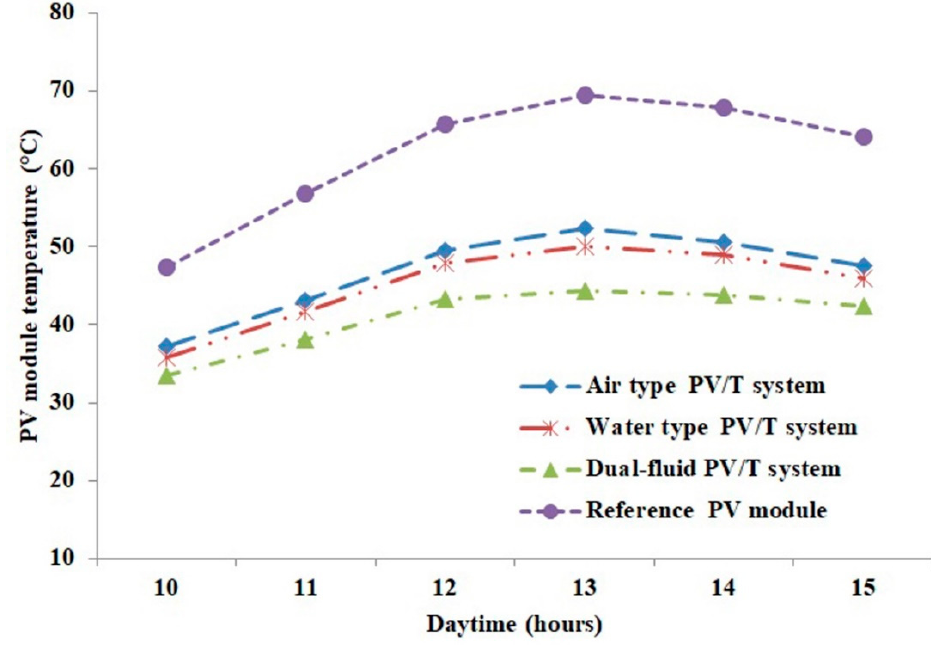
Figure 5. Daily photovoltaic (PV) module temperature plotted against different fluid operations.